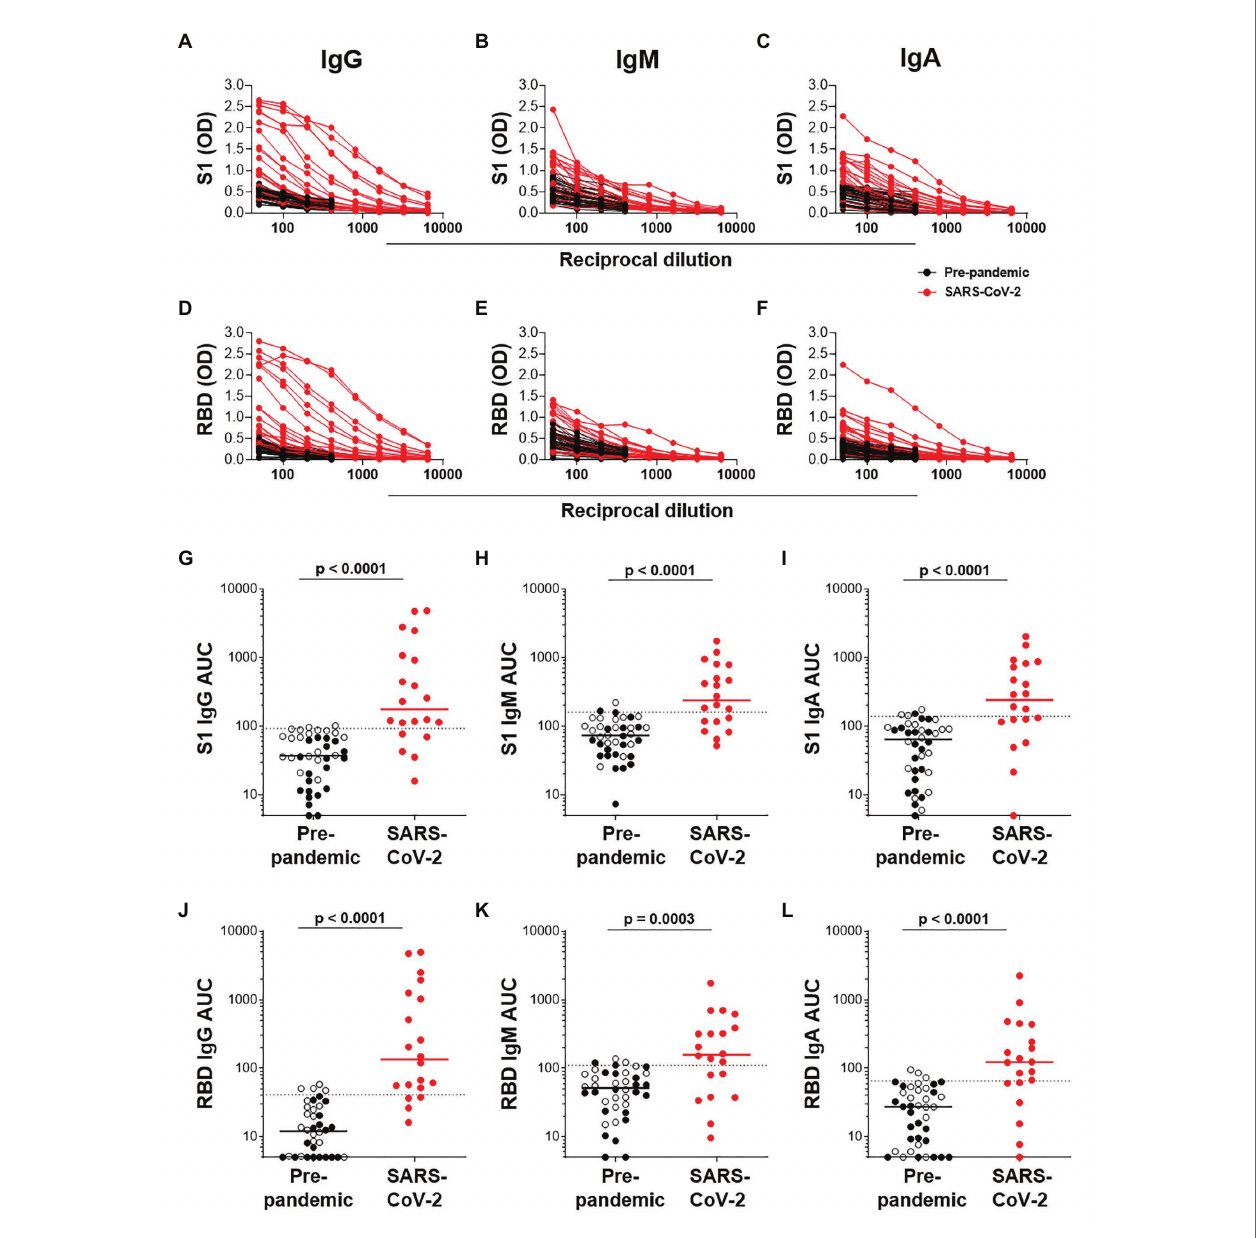
FIGURE 4 | Semi-quantitative detection of S1- and RBD-specific IgG, IgM, and IgA. Two-fold dilution series of sera for detection of S1-specific IgG (A) , IgM (B) , and IgA (C) and RBD-specific IgG (D) , IgM (E) , and IgA (F) . COVID-19 convalescent volunteers ( n = 20) are indicated in red, and pre-pandemic controls ( n = 40) are indicated in black. (G–I) and (J–L) ; Data from the same experiment as in (A–C) and (D–F) , respectively, but plotted as area under the curve (AUC). Horizontal lines represent median values. Dotted lines indicate the threshold for positivity. Statistical analyses were performed using a Mann-Whitney U test. A value of p < 0.05 was considered statistically